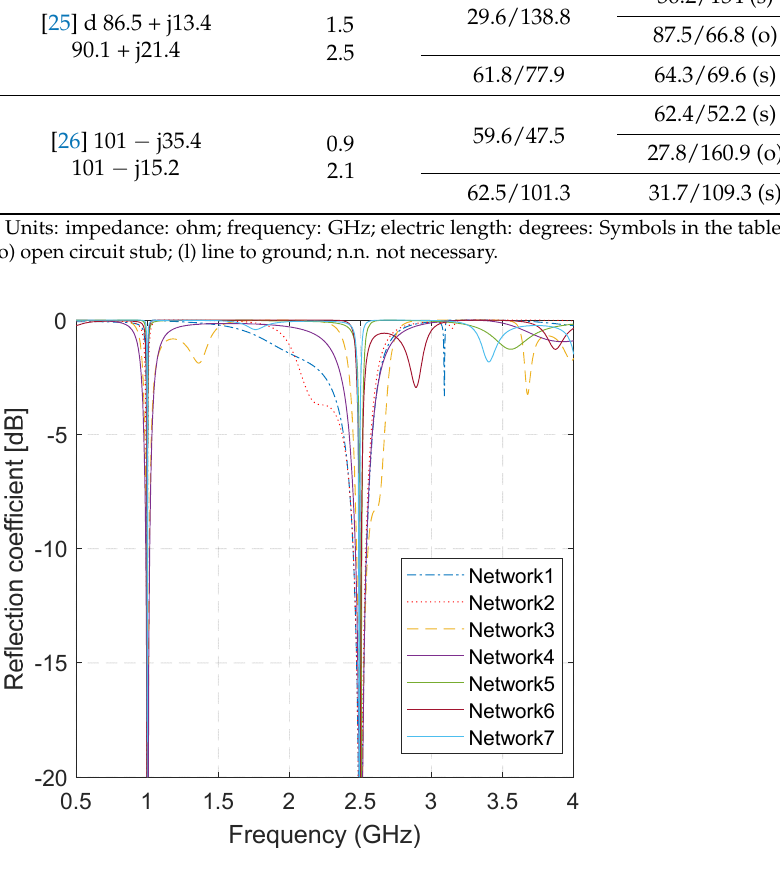
Table 1. Some examples of the matching results 1 .